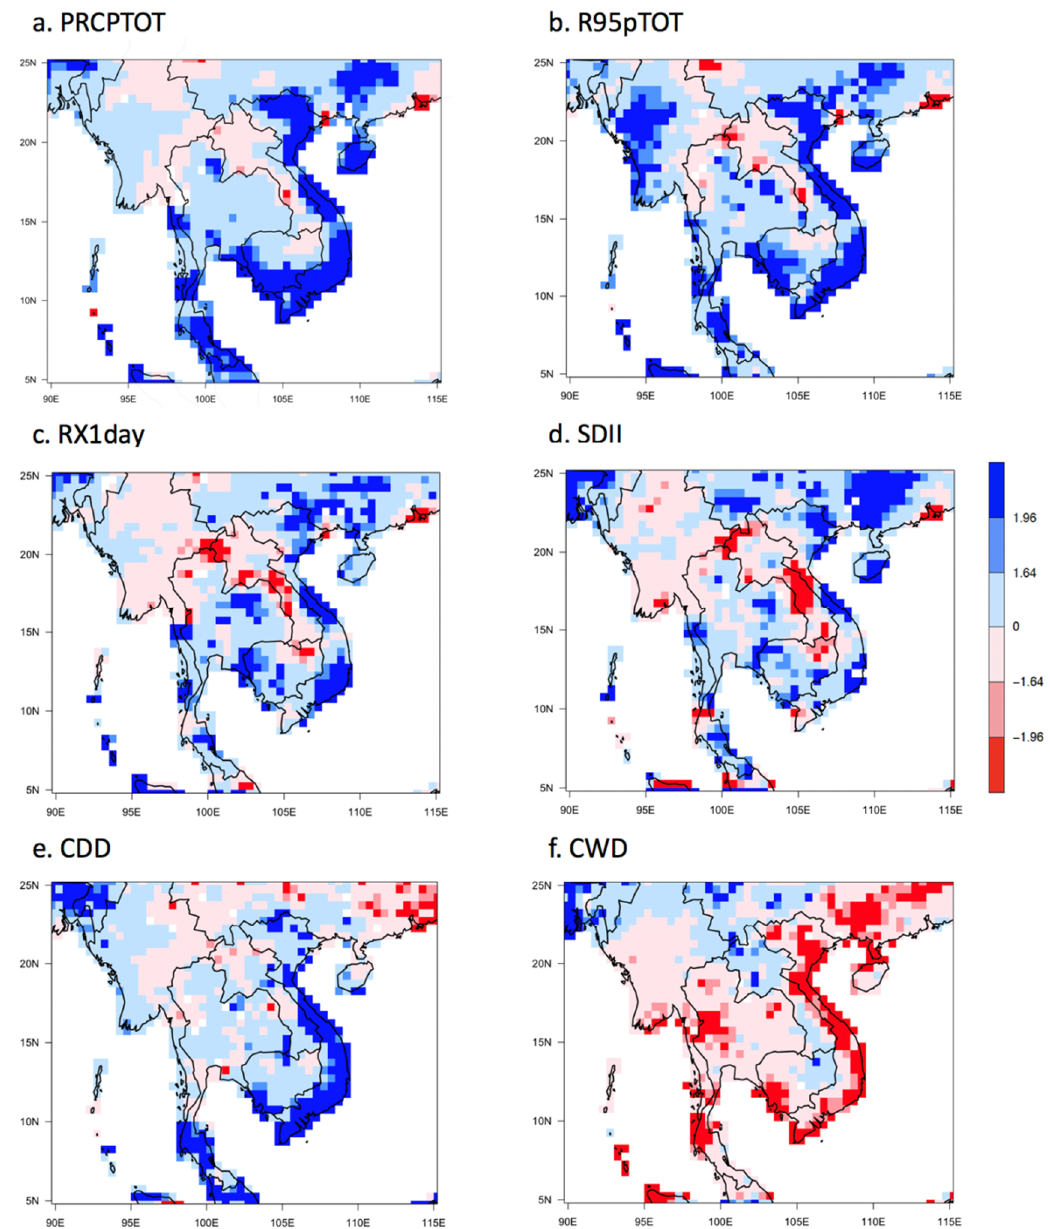
Figure 6. Long-term trend in seasonal precipitation for the dry season (November–April) over the ICP during 1979–2018. ( a – f ) show the analysis results of the six major climate change indices that reflect the magnitude and frequency of precipitation. In each panel, positive and negative trends are displayed in blue and red, respectively. The magnitude of Z is associated with the significance level, i.e., | Z | > 1.64 is for the 10% significance level and | Z | > 1.96 is for the 5% significance level.